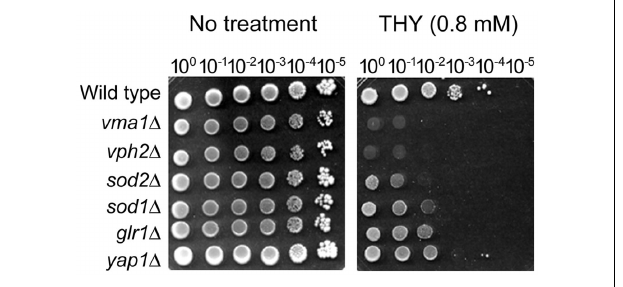
FIGURE 2 |Yeast dilution bioassay showing the sensitive response of Saccharomyces cerevisiae gene deletion mutants, i.e., vacuolar ( vph2 Δ , vma1 Δ ) and antioxidant ( sod2 Δ , sod1 Δ , glr1 Δ , yap1 Δ ), to thymol (THY). Although few colonies of yap1 Δ mutant appeared at the dilution spots 10 − 3 and 10 − 4 , where the wild type colonies also appeared, yap1 Δ mutant was also considered to be sensitive toTHY. Results shown are representative data from treatment with 0.8mM ofTHY.